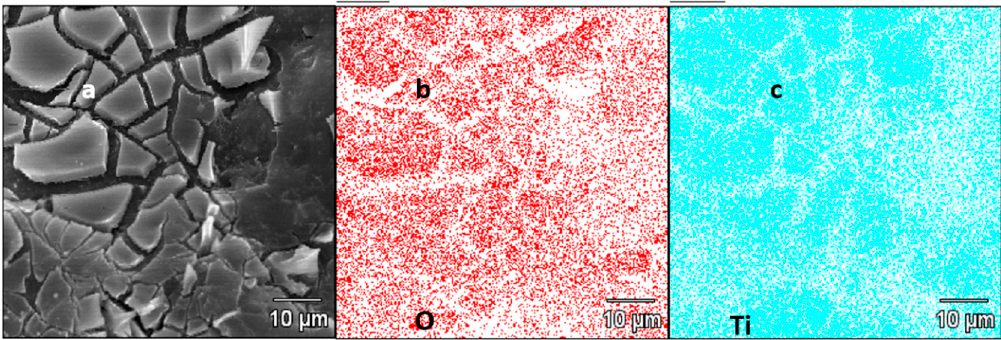
Figure 3. Scanning electron microscopy images of the ( a ) AC, ( b ) AC + TiO 2 , and ( c ) AC+ TiO 2 + S samples. Scale bars 3 μ m.